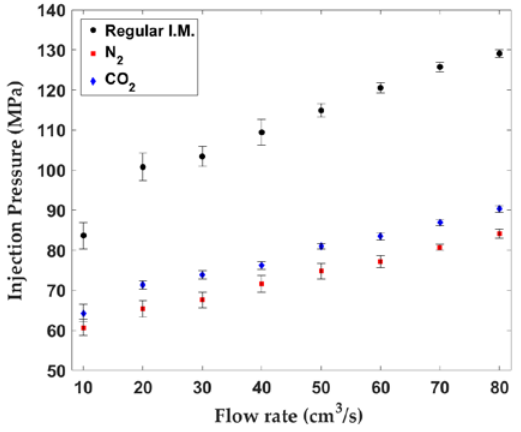
Figure 7. Injection pressure versus flow rate.